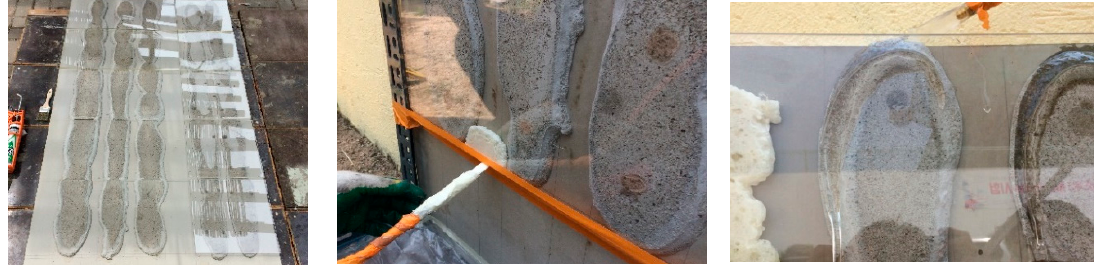
Figure 4. Test method for the permeability of the epoxy resin adhesive (mockup).